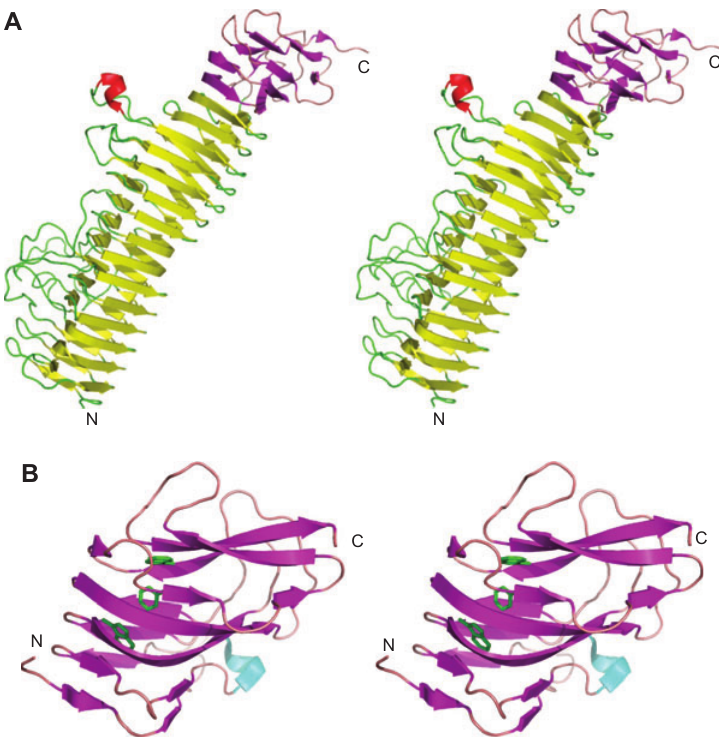
Figure 3 Models of autotransporter passengers. (A) Stereo view of the crystal structure of pertactin (p69), PDB entry 1DAB. A short helix is shown in red. β -Strands are shown as arrows, in yellow for the N-terminal region (residues 1 – 432), and purple for the junction-like AC domain (residues 433 – 539). A homology model of the junction region of BrkA (residues 601 – 692) may be built using this model. (B) Stereo view of the AC region of IcsA/VirG, PDB entry 3ML3. This is a stable fragment identifi ed by limited proteolysis (79) . The model is coloured by secondary structure in the same way as the AC domain of pertactin in (A). Buried tryptophan and phenylalanine residue side chains are shown as green